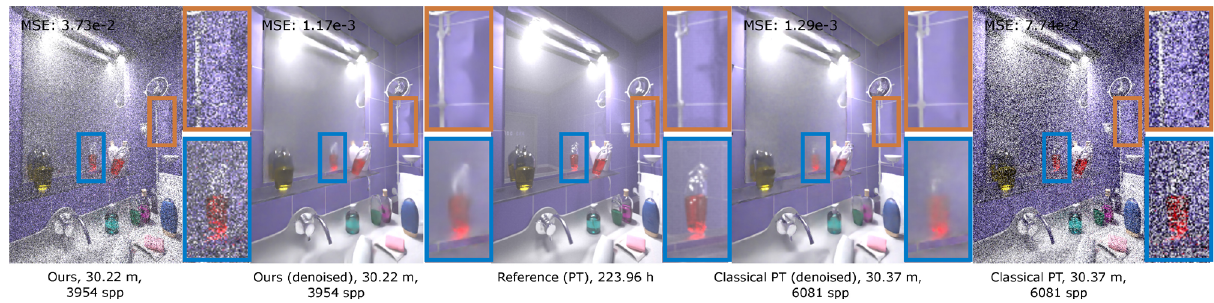
Fig. 14 Comparison of our method and path tracing with equal time for the Bathroom scene.